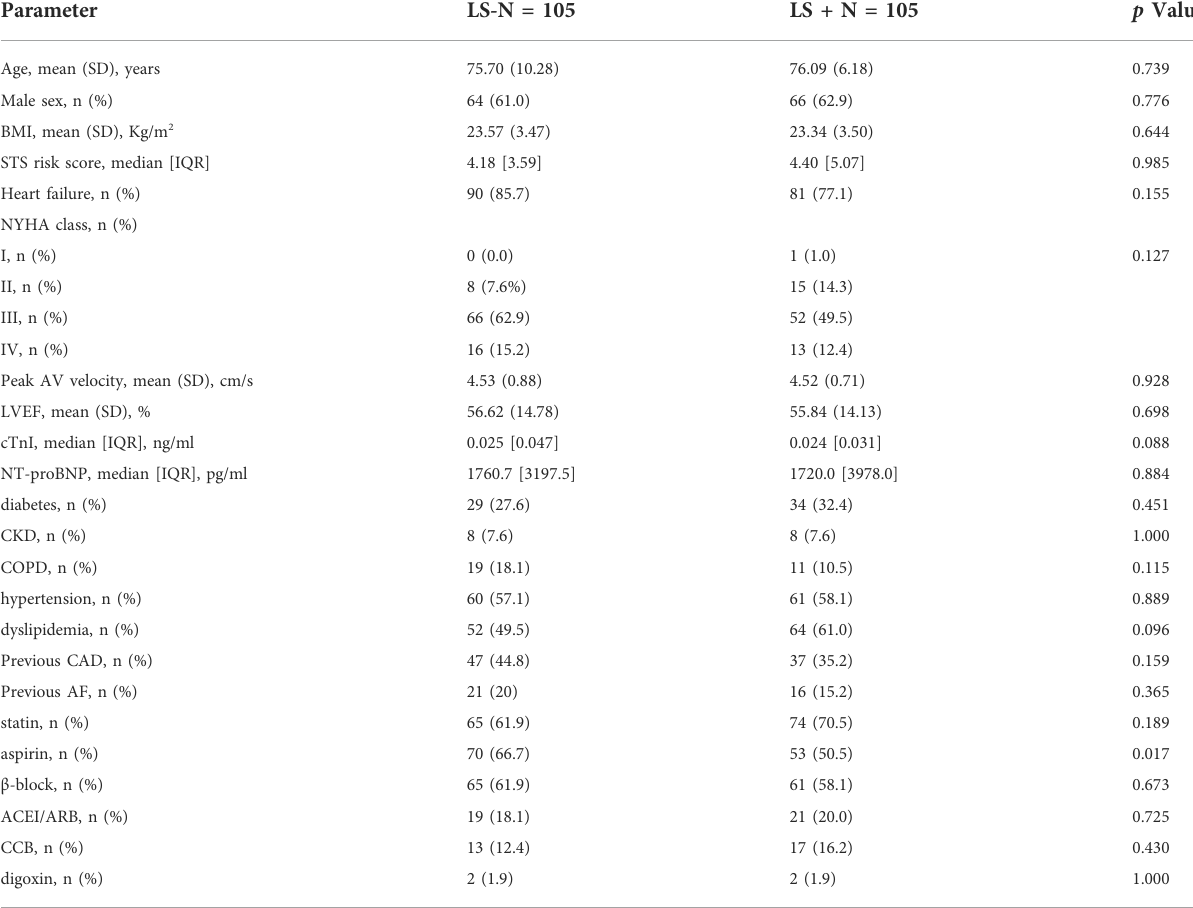
TABLE 1 Baseline characteristics for matched study population.